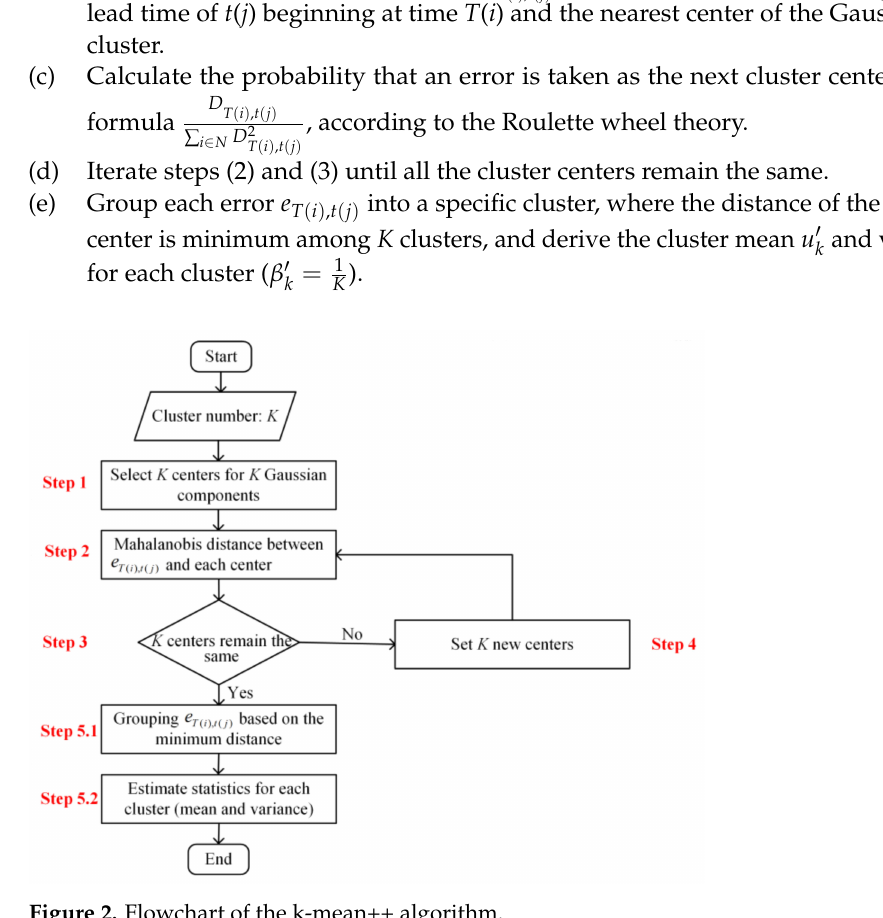
Figure 2. Flowchart of the k-mean++